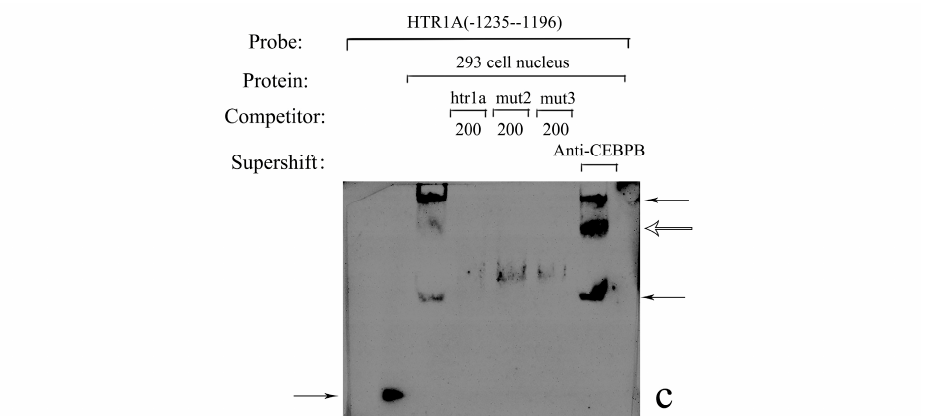
Figure 2. ( a ) EMSA identified CEBPB bound to the − 1219 bp to − 1209 bp fragment, ( b ) A synthesized